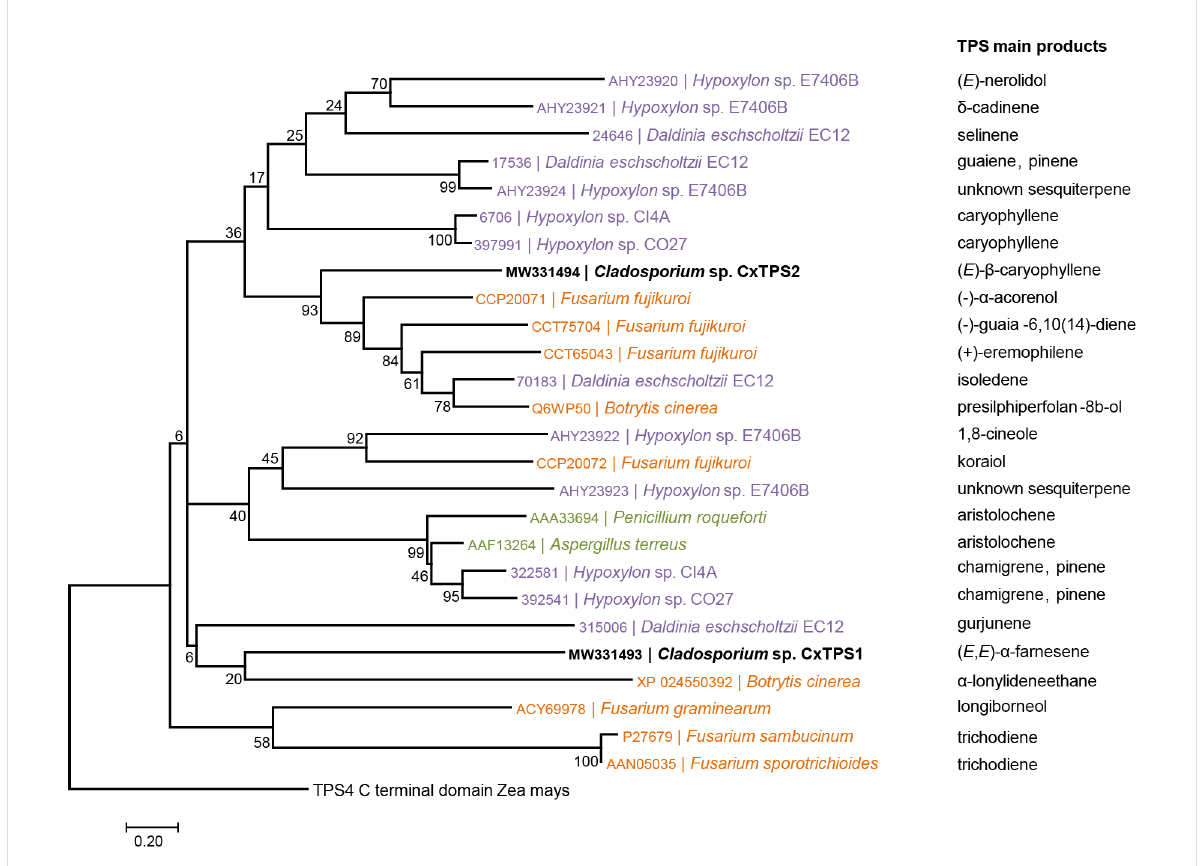
Figure 3: Dendrogram analysis (rooted tree) of CxTPS1 and CxTPS2 (bold) from Cladosporium sp. and characterized TPS proteins and their main products from other plant-associated Ascomycota. The tree was inferred using the Maximum Likelihood method based on the Poisson correction model and n = 1000 replicates for bootstrapping. Bootstrap values are shown next to each node. The tree is drawn to scale, with branch lengths measured in the number of amino acid substitutions per site. The alpha-domain of maize TPS4 [62] was chosen as an outgroup. TPS proteins from different Ascomycota are highlighted according to their different lifestyle: endophytic (purple), pathogenic (orange) and saprophytic (green).